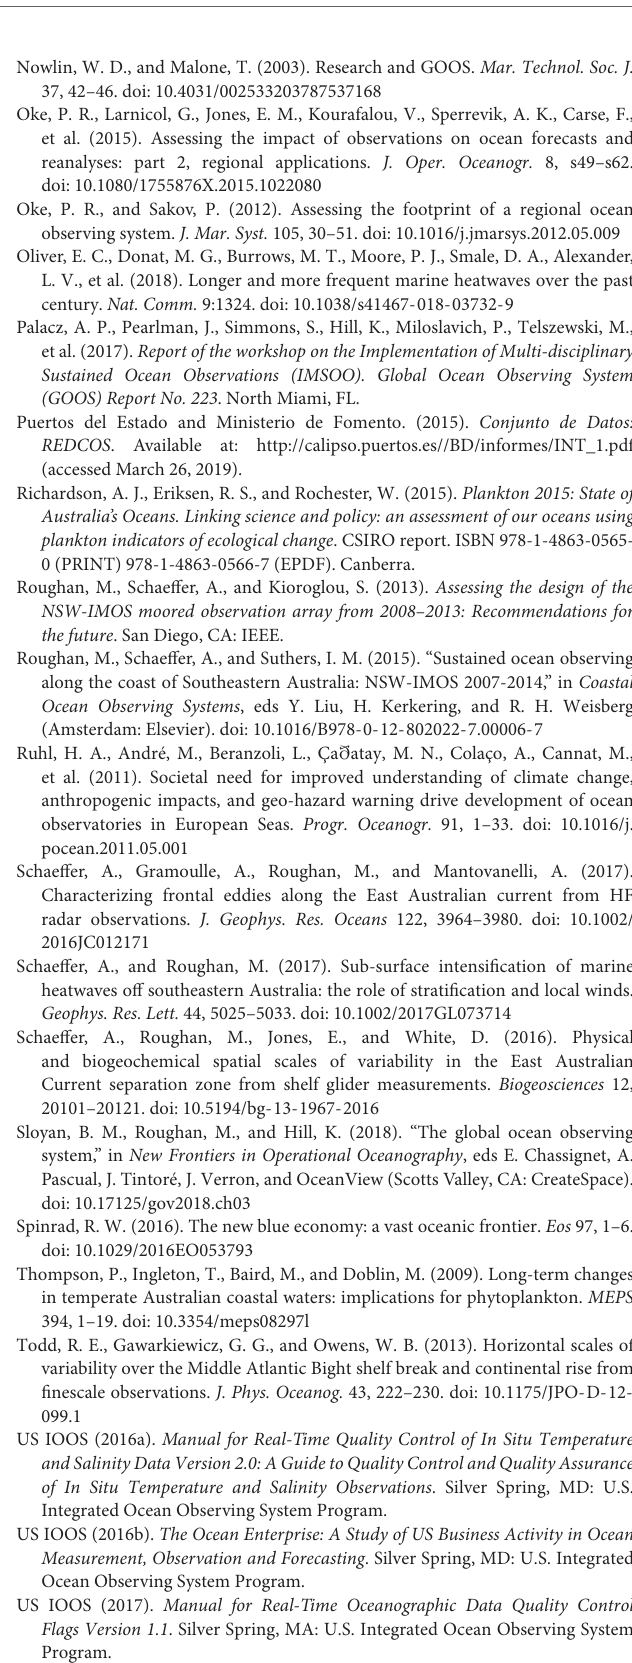
Flags Version 1.1 . Silver Spring, MA: U.S. Integrated Ocean Observing System